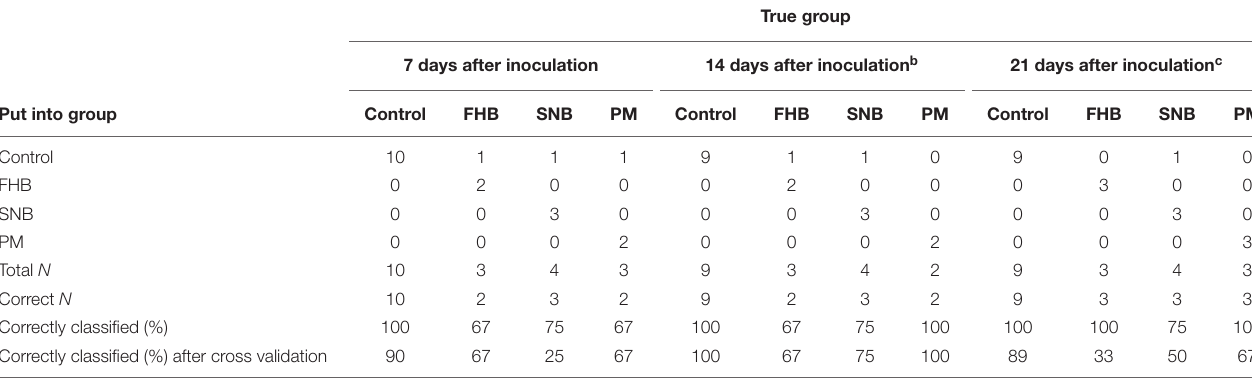
TABLE 8 | Summary of classification of fungal diseases on ‘Bjarne’ with “disease” [control, Fusarium head blight (FHB), Septoria nodorum blotch (SNB), and powdery mildew (PM)] as the response and different VOCs as the predictors.